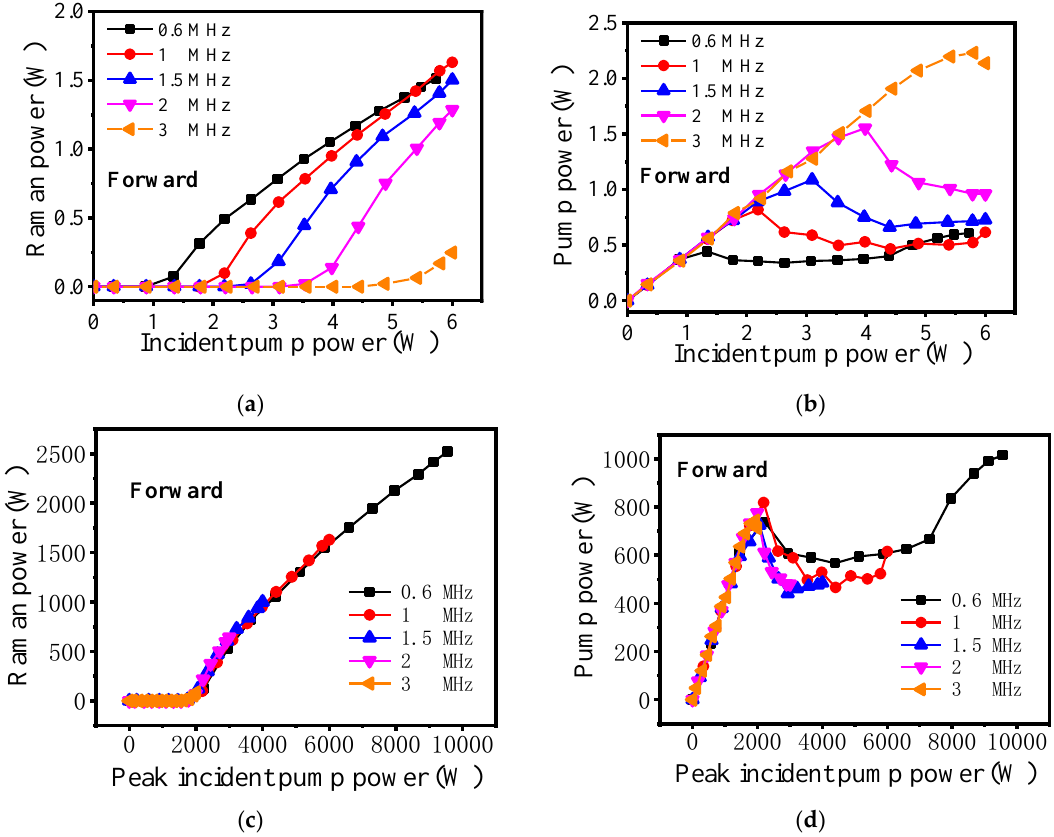
Figure 5. The characteristics of the forward output power with the incident pump power: ( a ) Raman power. ( b ) Pump power. The characteristics of the forward peak output power with the peak incident pump power: ( c ) Raman power. ( d ) Pump power.